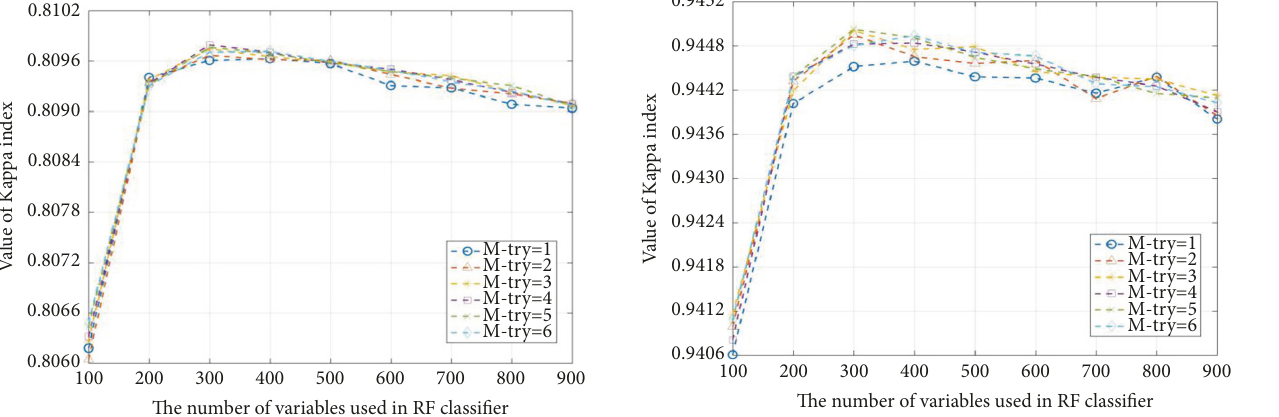
Figure 11: The tendencies of kappa when the N tree and M try are setting different values for AVIRIS.